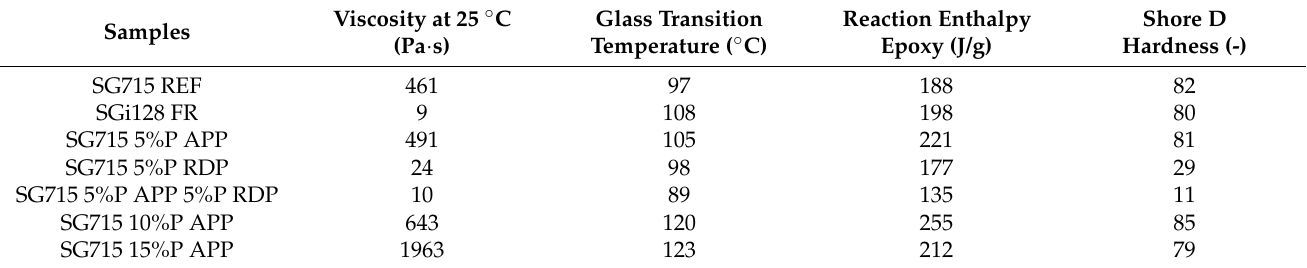
Table 2. Effect of flame retardants on the viscosity, glass transition temperature, reaction enthalpy, and Shore D hardness of gel